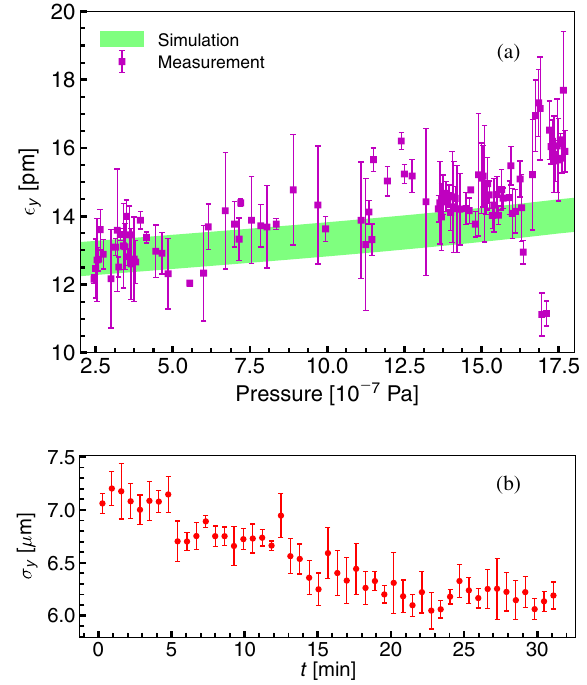
FIG. 11. Evaluation of vertical emittance with respect to vacuum pressure of the ring (a) and evolution of beam size measured by XSR when all SIPs were reset at t ¼ 0 (b). Band width of the vertical emittance estimated by simulation is due to the 10% uncertainty for the determination of the vertical emittance in absence of ∼ 10 − 6 Pa and should be taken into account in the design of low-emittance storage ring.